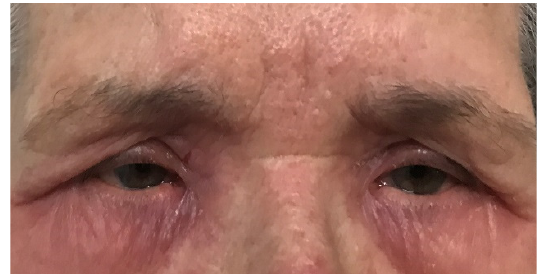
Figure 3. Periocular atopic dermatitis